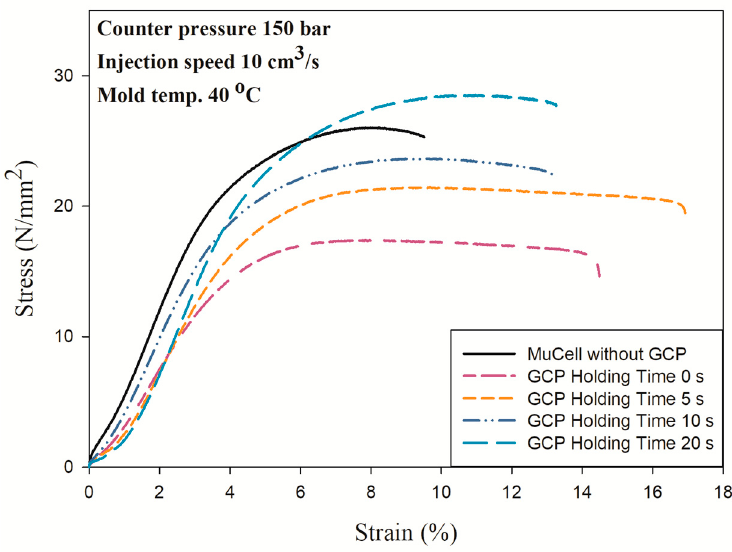
Figure 14. Stress–strain curves of microcellular injection-molded PP with GCP of 150 bar and different holding times.